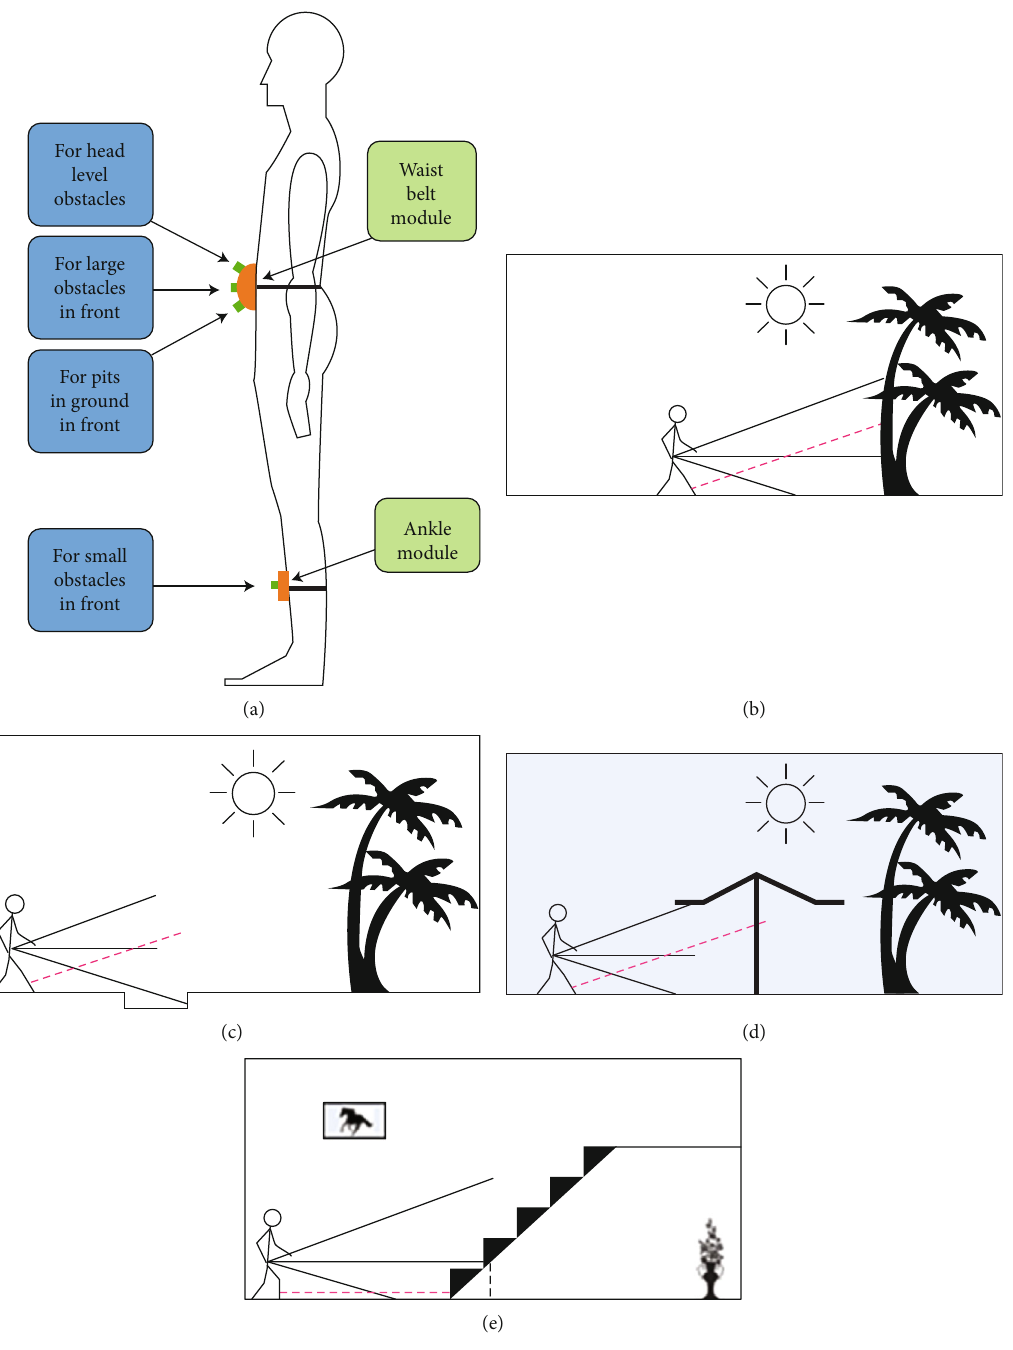
Figure 2: Evaluation for design consideration of an assistive device for visually impaired people. (a) Layout of the device. (b) Obstacle at head level. (c) A pit hole on a straight path. (d) Obstacle upfront. (e) Stairs or small obstacle in